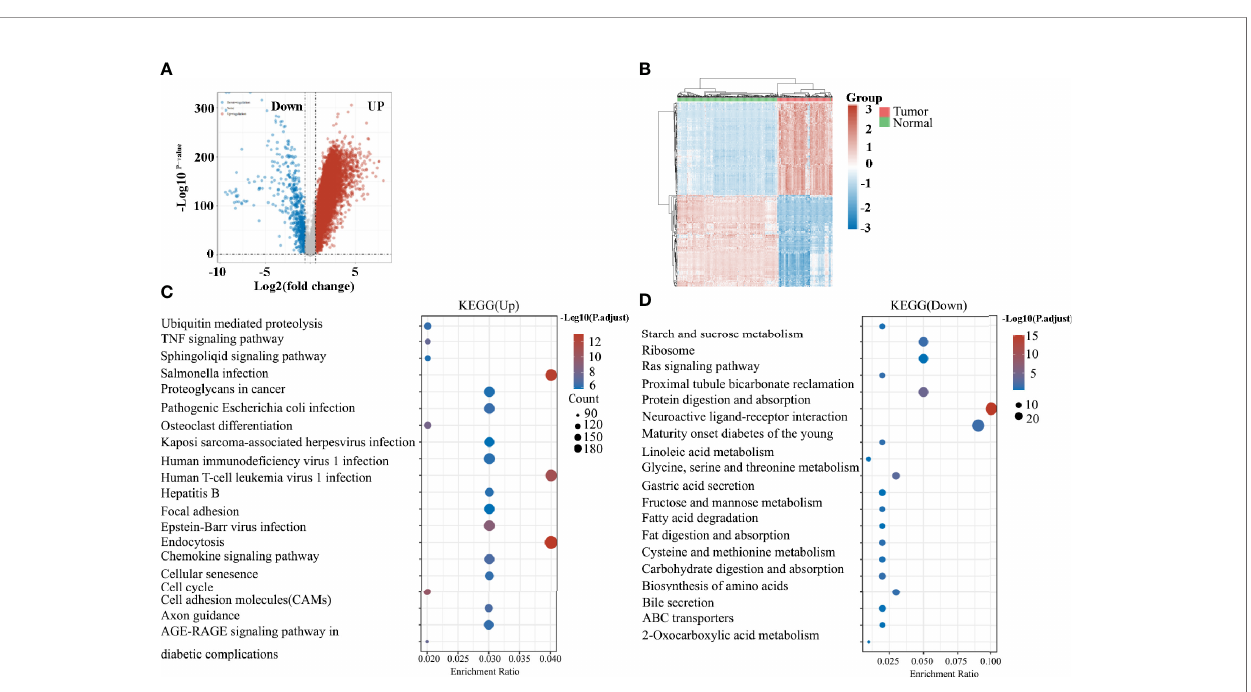
FIGURE 2 | (A) Volcano plots constructed using fold-change values and adjusted P values. The red point in the plot represents the over-expressed mRNAs and the blue point indicates the down-expressed mRNAs with statistical signi fi cance. (B) Hierarchical clustering analysis of mRNAs, which were differentially expressed between tumor and normal tissues. (C) The top 20 upregulated KEGG signaling pathways in tumors. (D) The top 20 downregulated KEGG signaling pathways in